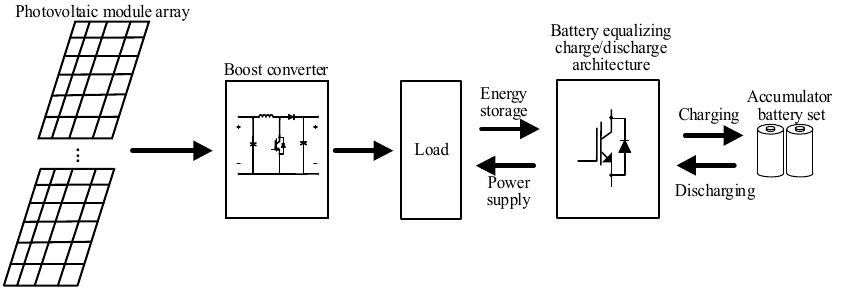
Figure 1. Architecture of the PMA combined with the energy storage battery system with equalizing charge/discharge